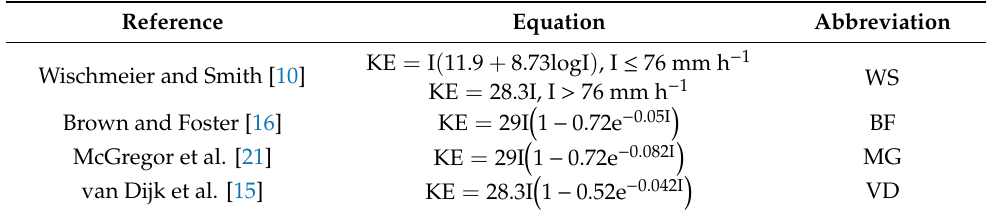
Table 1. Relationships between kinetic energy, KE (J m − 2 h − 1 ) and intensity, I (mm h − 1 ).